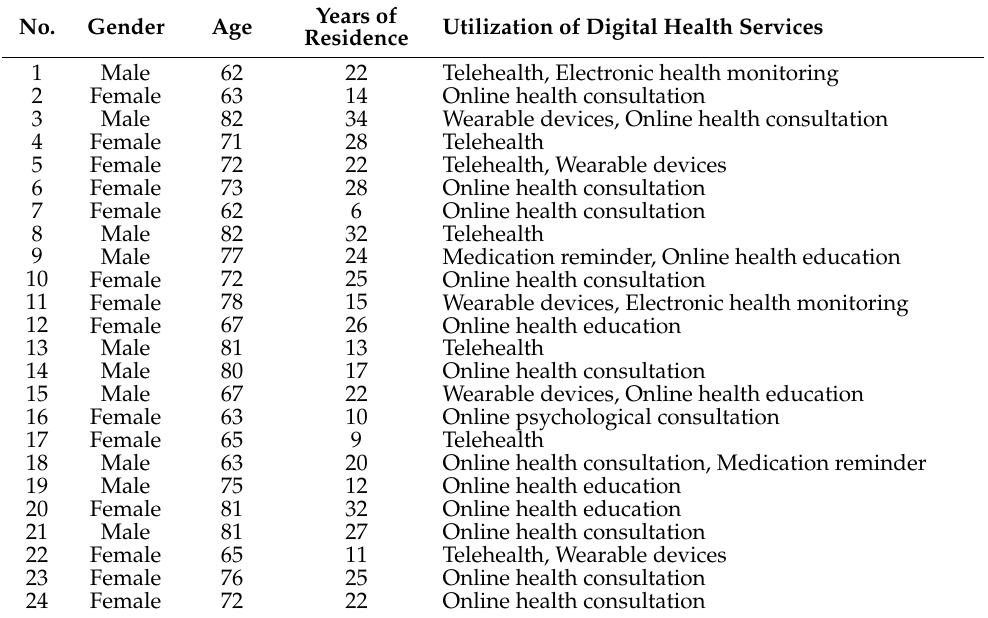
Table 6. Demand-side interviewer information.